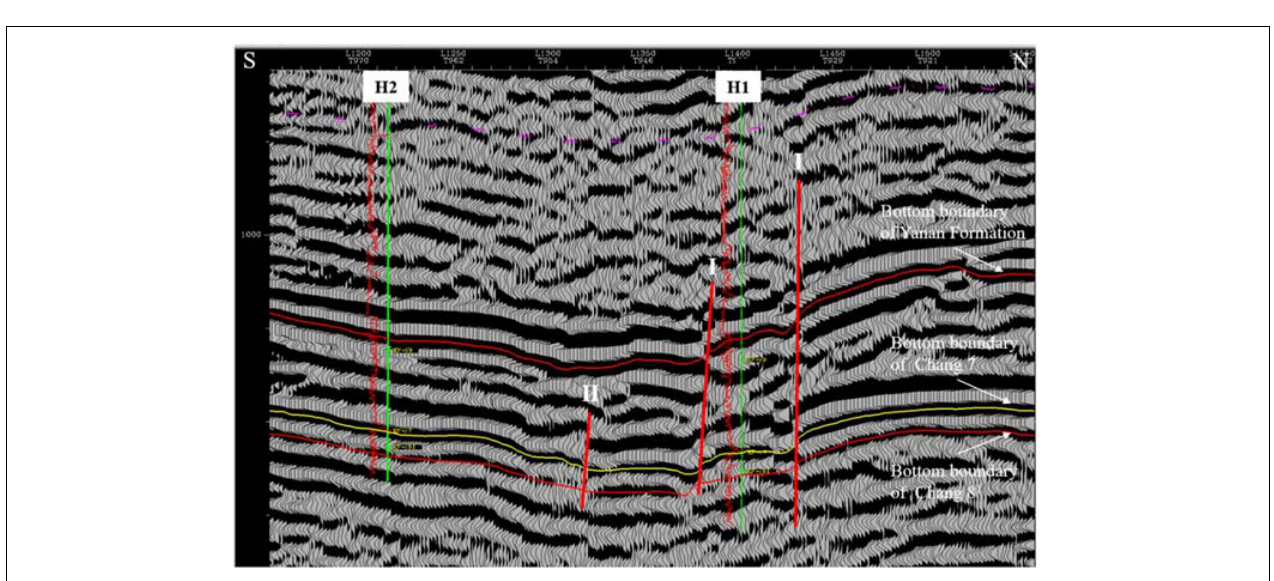
FIGURE 4 | Type-I and type-II faults on the seismic cross-section. I refers to the type-I fault. II refers to the type-II fault. H1 and H2 refer to drilling wells, see Figure 1 for the well location.